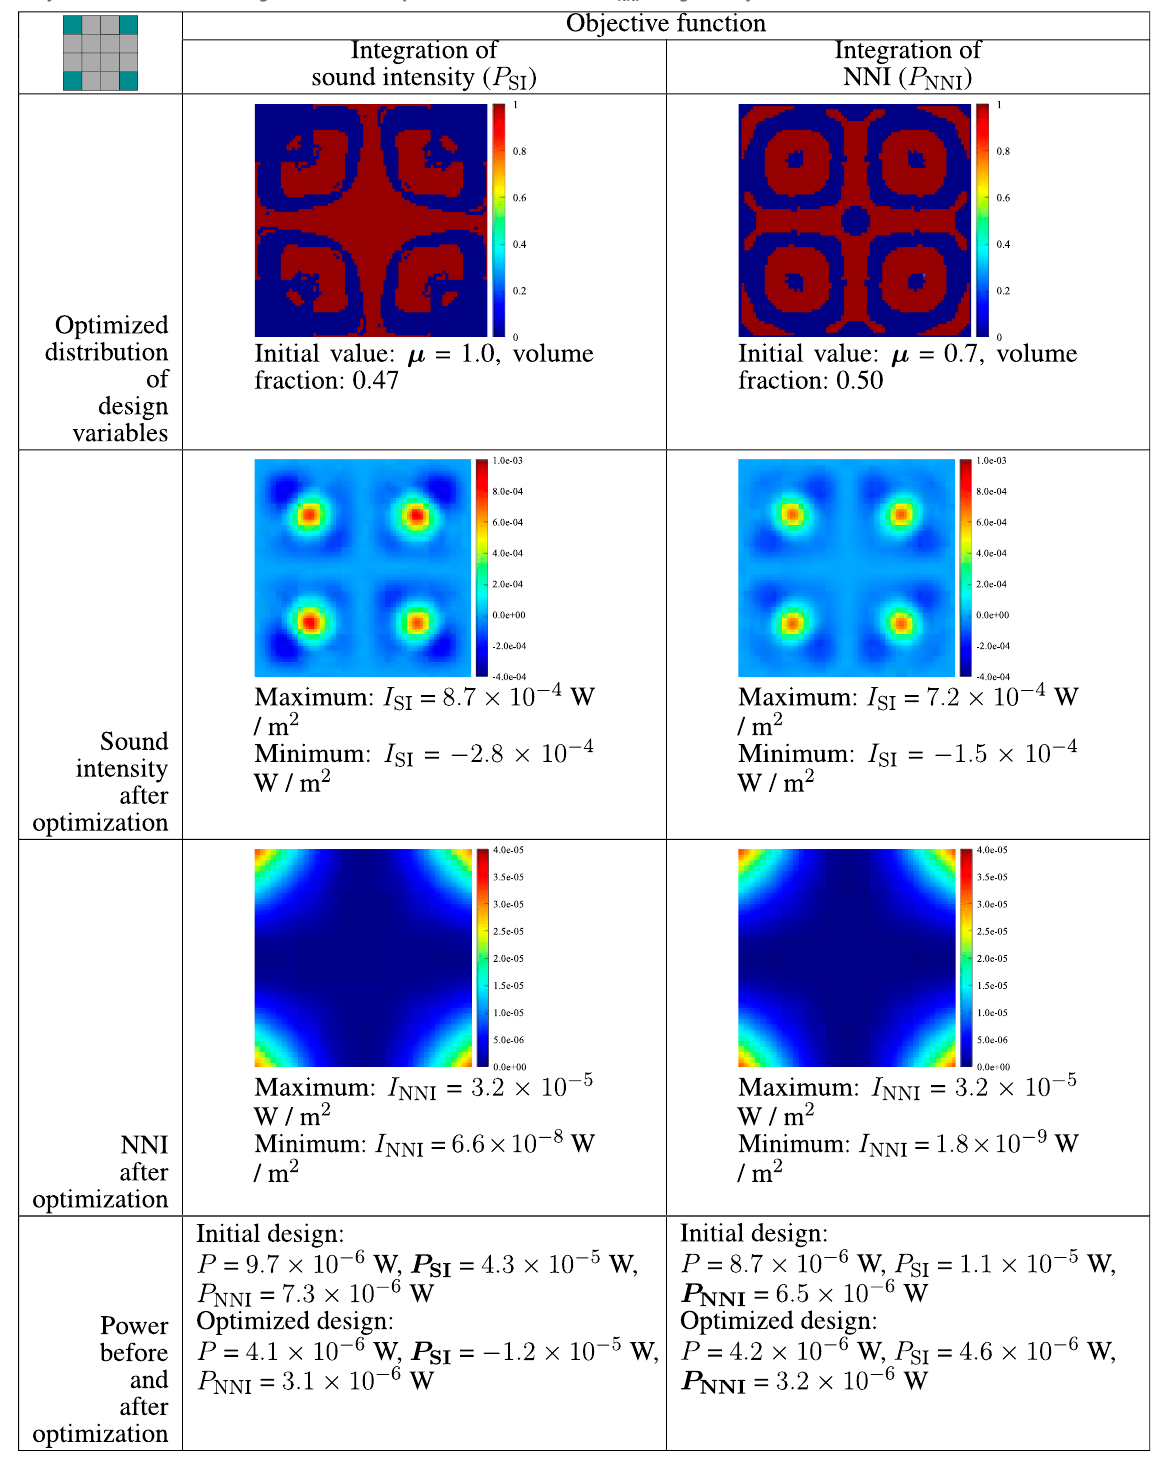
uniform distribution of design variables. From Figures 9C, D, we Figure 10 presents the distributions of sound intensity as well as NNI of the initial design ( fi rst row) and two optimized designs (second and third rows). To achieve a better optimization result, we conduct the optimization with different initial values of the design variable: μ = 0.7 and μ = 1 and then show the better one here.